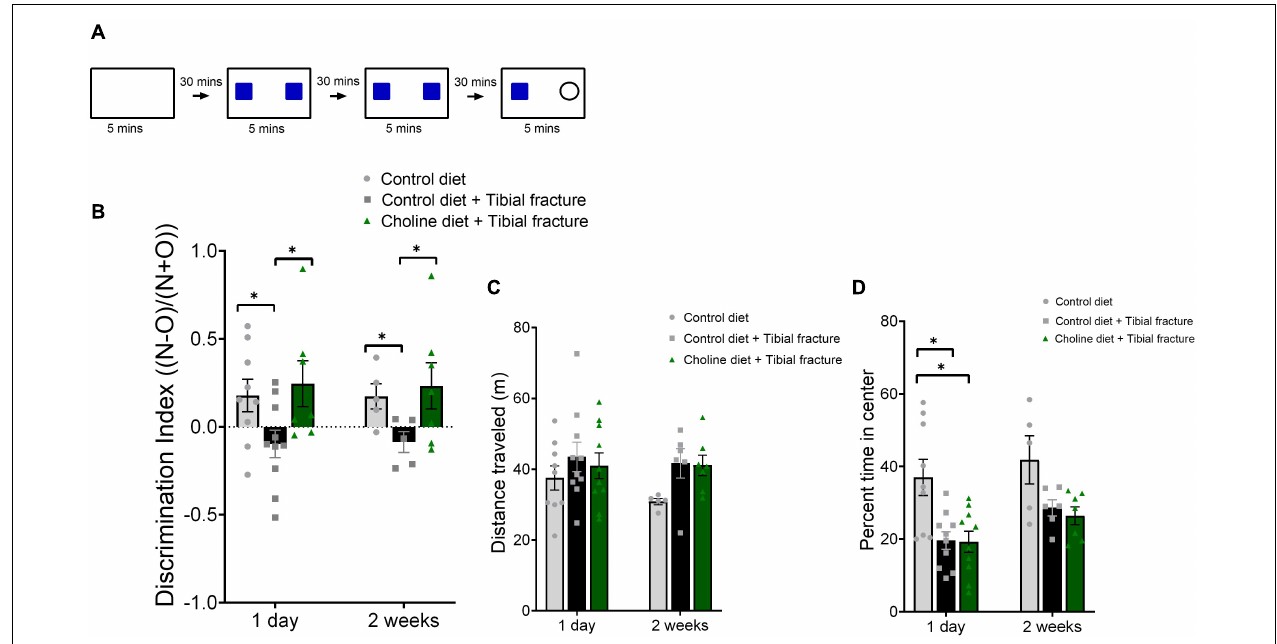
FIGURE 3 | (A) Schematic indicating novel object recognition (NOR) protocol. (B) Histogram showing discrimination index [(Novel object time − Old object time)/(Novel object time + Old object time)] 1 day and 2 weeks after surgery. N = 5–10 per group. ∗ p < 0.01, Tukey HSD. Each bar represents the mean ± SEM. (C) Tibial fracture surgery and choline supplemented diet did not alter activity of mice in an open field task. Histogram showing the distance traveled in meters over the 5 min trial. N = 5–10 per group. Each bar represents the mean ± SEM. (D) Tibial fracture surgery and choline supplemented diet effects on percent of time spent in the center of the arena (anxiety-related behavior) in an open field. Tibial fracture decreased the percent time in the center of the arena, and this effect was not rescued by dietary choline supplementation. Histogram showing the percent of time spent in the center of the arena over the 5 min trial. N = 5–10 per group. ∗ p < 0.05, Tukey HSD. Each bar represents the mean ±